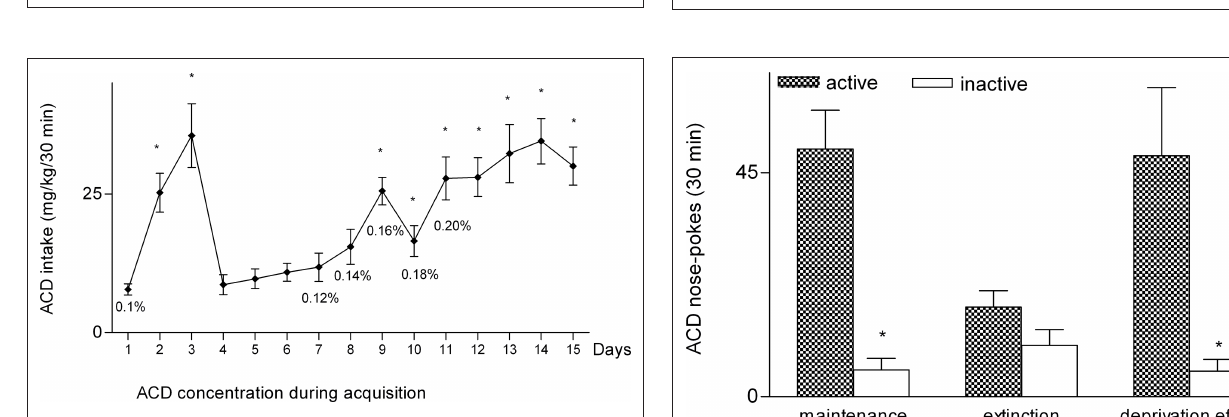
Figure 3 | Average number of active nose-pokes during the last three sessions of oral self-administration as a function of ACD concentration (each ACD concentration was tested for 5 days) in Wistar rats. Asterisk indicate significant difference ( p < 0.05) with Tukey’s test. Data are mean ± SEM.